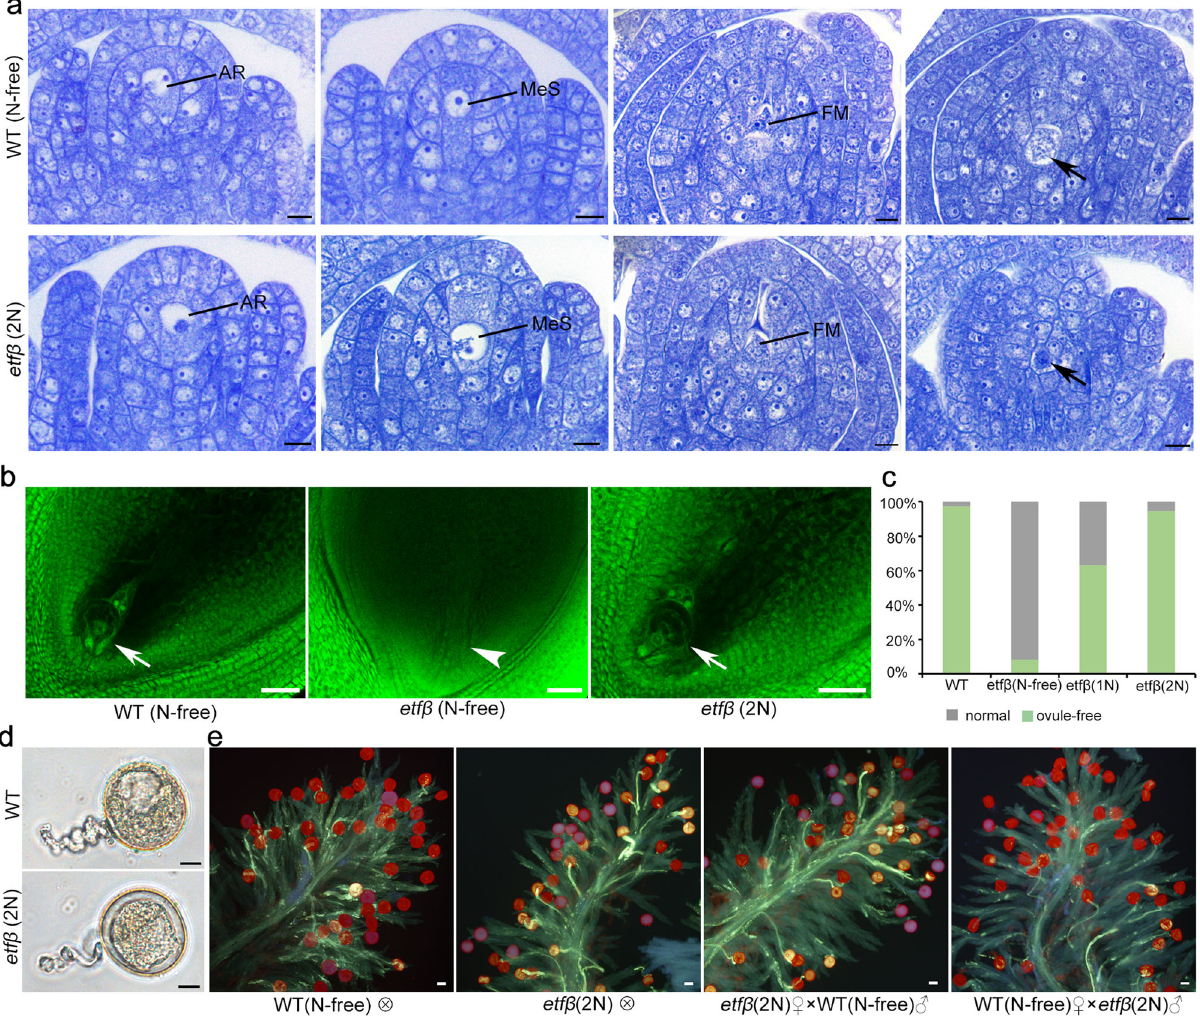
Fig. 3 Both male and female gametogenesis in etf β can be completely rescued by applying excess N. a Longitudinal sections of ovules stained with TBO from WT treated with N-free nutritional solution [WT (N-free)] and etf β treated with Hoagland solution with twice the normal N concentration [ etf β (2 N)]. AR, archesporial cell; FM, functional megaspore; MeS megasporocyte. Scale bars, 10 µ m. b Mature ovules of WT and etf β treated with three different concentrations of N: etf β (N-free), etf β (1 N), and etf β (2 N). White arrows point to normal ovules, and the white arrowhead points to an ovule without an embryo sac. Scale bars, 50 µ m. c The proportion of normal and ovule-free embryo sacs in WT (N-free) and etf β treated with three different concentrations of N: etf β (N-free), etf β (1 N), and etf β (2 N). The Y -axis indicates the corresponding ratio. n ≥ 36. d , e Comparison of pollen activity between WT (N-free) and etf β (2 N). d In vitro germination of WT and etf β (2 N) pollen. Scale bars, 10 µ m. e In vivo WT and etf β (2 N) pollen germination and pollen tube elongation. Scale bars, 50 µ m. Source data are provided in the Source Data fi